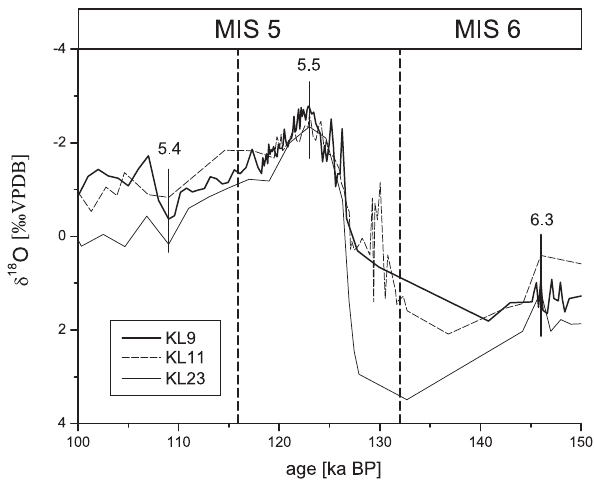
Fig. 2. Age models of the sediment cores used in this study: δ 18 O records from KL9 and KL11 (data from Rohling et al. (2008b)) and KL23 (data from Badawi et al. (2005)) (control points 6.3, 5.5 and 5.4 as indicated by vertical lines). Dashed vertical lines mark the MIS 5e/d (116ka BP) and MIS 6/5e boundary (132ka BP, Shackle- ton et al.,